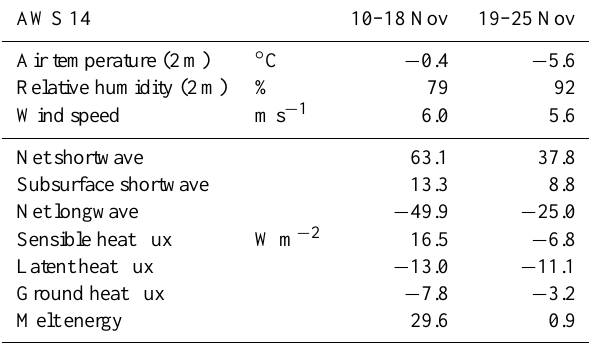
Table 3. Means of SEB components and meteorological